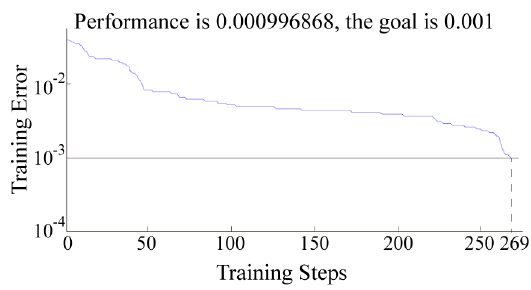
Figure A1. Error training curve.